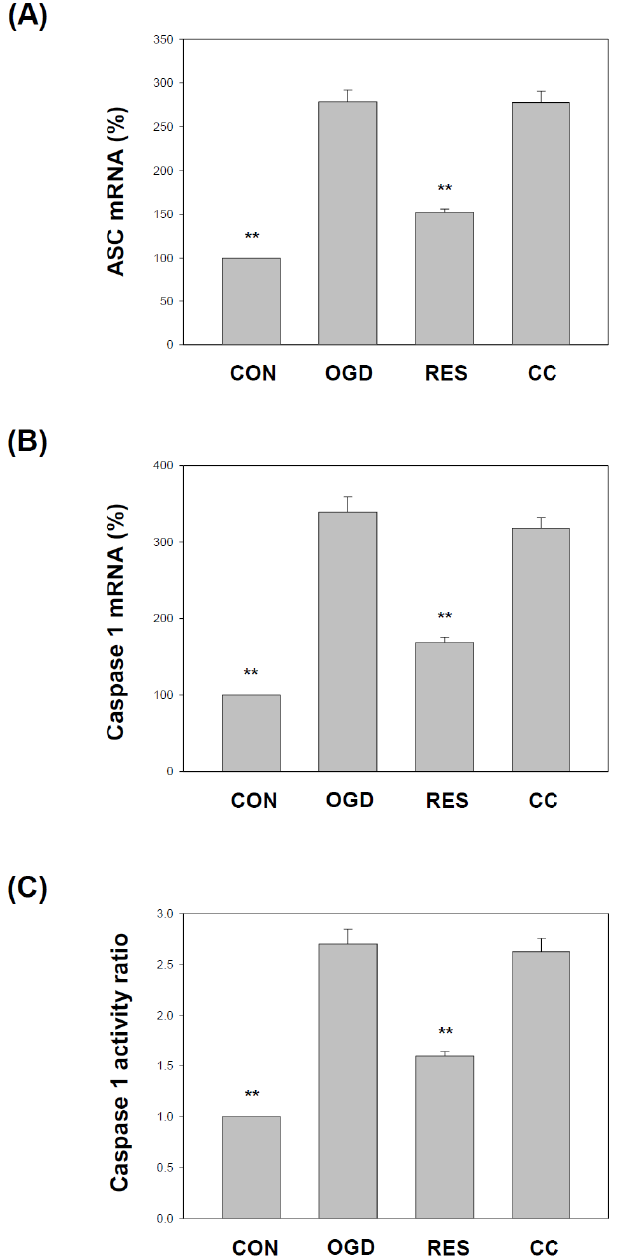
Figure 5. Resveratrol improves the ASC and Caspase 1 levels in OGD-induced cells in the 3D scaffold. The cell experiments under the scaffolds were divided into four groups, as described in Figure 1 and the methods section. Use qPCR to analyze ASC ( A ) and Caspase 1 ( B ) mRNA transcripts. Collect total RNA from SH-SY5Y cells and reverse transcribe it into cDNA. Perform qPCR on the specified gene and normalize it to GAPDH expression. ( C ) Caspase 1 activity was detected by a fluorometric protease assay using substrate YVAD-AFC (AFC: 7-amino-4-trifluoromethyl coumarin). The value is expressed as a percentage of the transcript established in CON and the mean ± SEM value from three independent experiments. Specific comparison to the indicated SH-SY5Y cells with OGD ** p < 0.001 vs. cells with OGD.